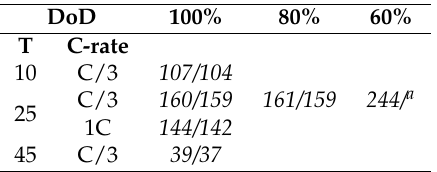
Figure 6. The influence of current rate on capacity retention over battery lifetime during cycling, where the black line indicates End of Life (EoL). Increases in SoH at Cycles 51 and 101 due to CCCV charge at the start of the cycling block, instead of consecutive C/3 charges. Table 4. Number of full equivalent cycles to end of life for both tested cells at every cycling